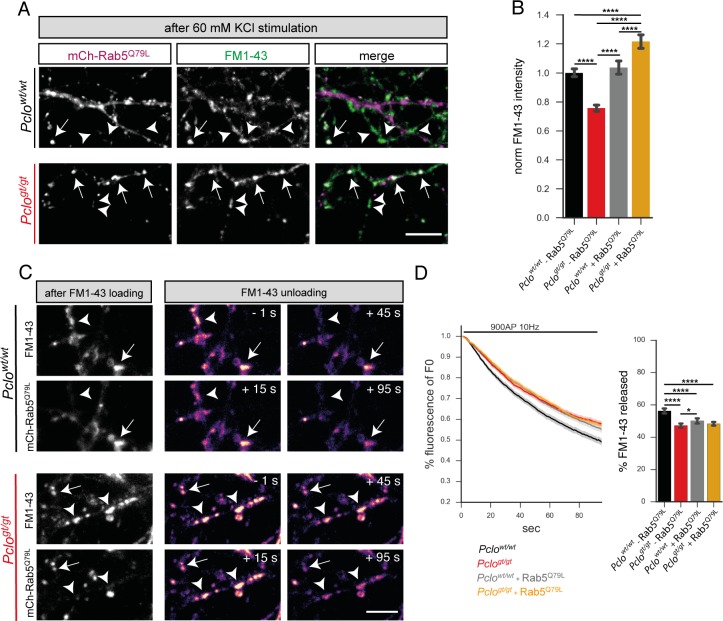
Expression of GTPase deficient Rab5 (Rab5Q79L) in Pclogt/gt neurons rescues the size of the total recycling pool of vesicles but not FM1-43 unloading kinetics.(A) Representative images showing FM1-43 levels in Pclowt/wt and Pclogt/gt boutons either positive (arrow) or negative (arrowhead) for mCh-Rab5Q79L after 60 mM KCl stimulation. (B) Quantification of (A). (Pclowt/wt = 1 ± 0.01, n = 528 puncta; Pclogt/gt = 0.76 ± 0.01, n = 654 puncta; Pclowt/wt
(mCh-Rab5Q79L)=1.04 ± 0.02, n = 304 puncta; Pclogt/gt
(mCh-Rab5Q79L)=1.22 ± 0.02, n = 337 puncta; three independent experiments). (C) Left: Images depicting FM1-43 intensities in Pclowt/wt and Pclogt/gt boutons either positive (arrow) or negative (arrowhead) for mCh-Rab5Q79L. Right: Images depicting FM1-43 unloading kinetics in Pclowt/wt and Pclogt/gt boutons either positive (arrow) or negative (arrowhead) for mCh-Rab5Q79L. (D) Quantification of (C). The presence of mCh-Rab5Q79L is not sufficient to rescue slowed FM1-43 unloading kinetics and total amount of FM1-43 dye released in Pclogt/gt boutons (Pclogt/gt = 47.24 ± 0.68, n = 361 synapses; Pclogt/gt(Rab5Q79L)=48.33 ± 0.53, n = 479 synapses; four independent experiments). In Pclowt/wt boutons expressing mCh-Rab5Q79L, FM1-43 unloading kinetics are slowed and total amounts of dye released are reduced similar to what is observed in Pclogt/gt boutons (Pclowt/wt = 56.28 ± 0.81, n = 301 synapses; Pclowt/wt(Rab5Q79L)=50.15 ± 0.85, n = 342 synapses; four independent experiments). Scale bars represent 5 μm. Error bars in bar graph represent 95% confidence intervals. Numbers given represent mean ± SEM. ANOVA with Tukey multi comparison test. * denotes p<0.05, **** denotes p<0.0001.10.7554/eLife.46629.024Figure 8—source data 1.This spreadsheet contains the normalized values used to generate the bar plots shown in Figure 8B and D.